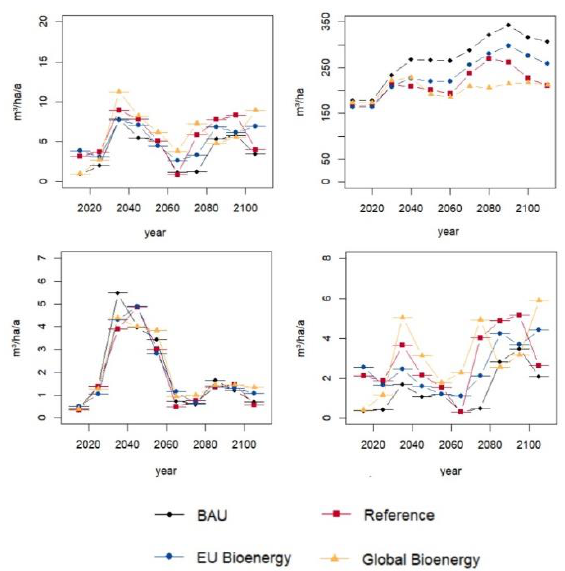
Figure 6. Annual harvested volume per hectare ( top-left ), standing volume ( top-right ), harvested sawlog volume ( bottom-left ) and harvested pulpwood volume ( bottom-right ) for the BAU and three global scenarios over the 100-year planning horizon. To show the trends, 10-year average values rather than actual annual volumes are presented. All values are in m 3 ha − 1 year − 1.